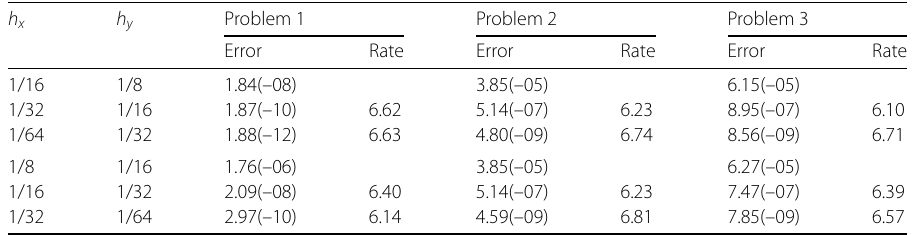
Table 7 The maximum error and convergence rate for Problem 1, Problem 2 with ε = 10 –1 and Problem 3 with Re =